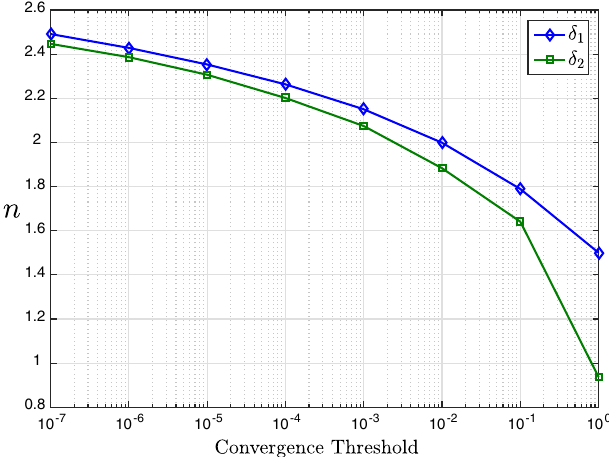
FIG. 4. Number of iterations vs convergence threshold. This plot shows the scaling of the number of iterations required by PHOM with the tightness of the convergence criterion. As commented in the text, two figures of merit assess this, δ 1 and δ 2 . The former is related to the distance between the sum of stabilizers and its maximum value, and the latter is associated with the maximum value among the distances for each stabilizer. The simulations have been done for the case of PHOM applied to individual mean